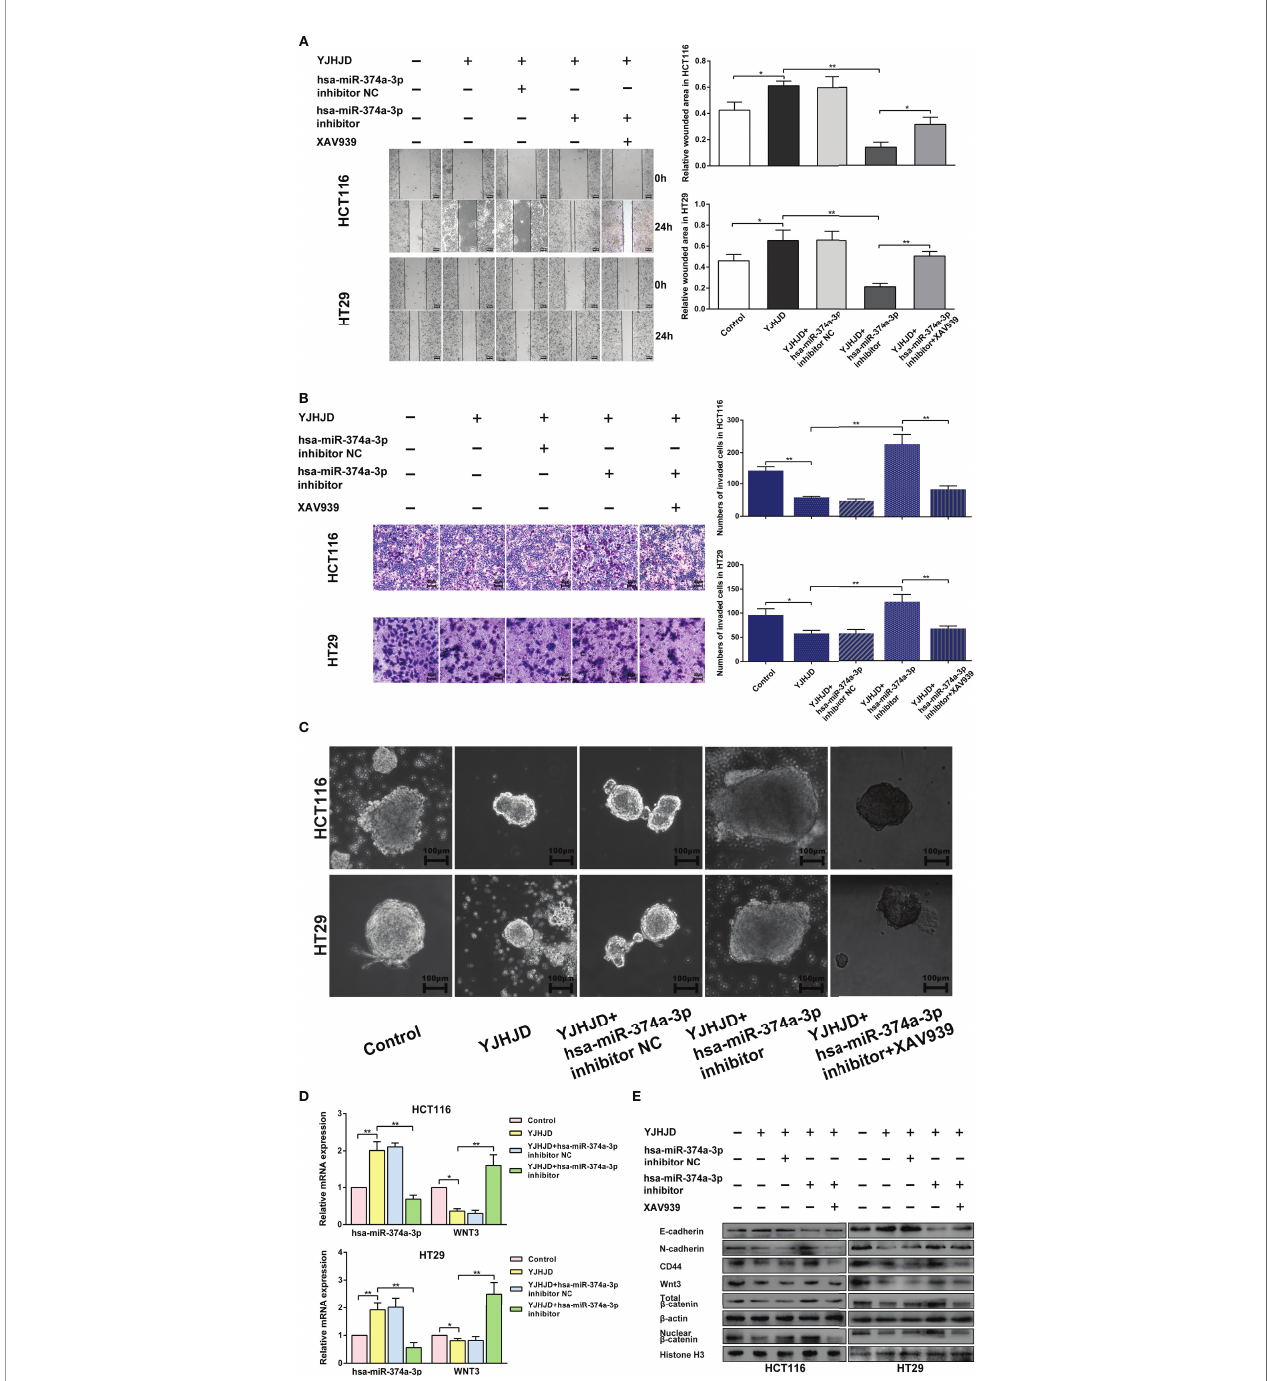
FIGURE 6 | The hsa-miR-374a-3p/WNT3/ b -catenin axis plays a vital role in the suppressive effect of YJHJD. (A) A wound-healing experiment was performed to test cell migration ability. (B) Transwell assay was performed to explore cell invasion ability. (C) Spheroid formation assay was carried out to appraise cellular plasticity. (D) Hsa-miR-374a-3p and WNT3 mRNA expression was detected by PT-PCR experiment. (E) WNT3/ b -catenin, EMT, and cellular plasticity-related protein expression was researched through Western blot assay. *P < 0.05, **P < 0.01 compared to control group. *P < 0.05, **P < 0.01 compared to control